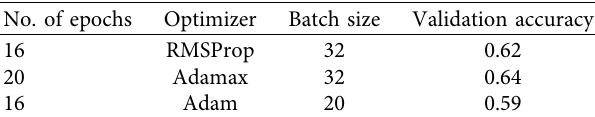
Figure 4: Confusion matrix obtained by using multimodal ap- proach on validation set. Table 2: Some of the best results obtained while training the model using sequential approach.